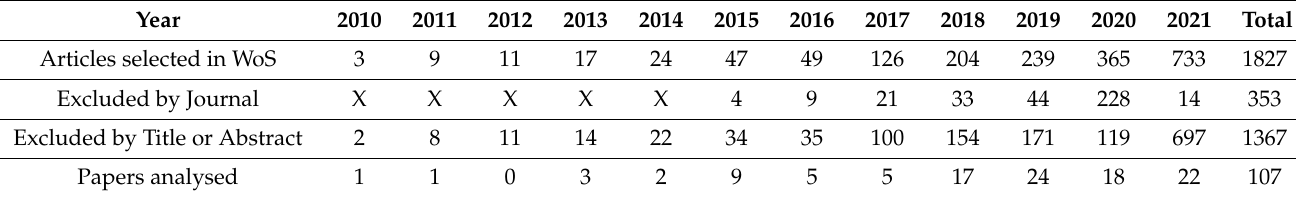
Table A2. Results of the selection